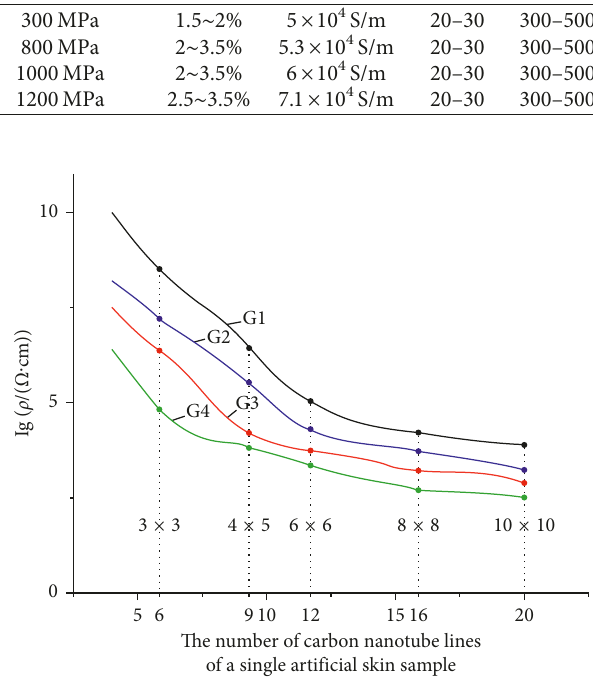
Figure 6: Relationship between quantity and resistivity of a single artificial skin